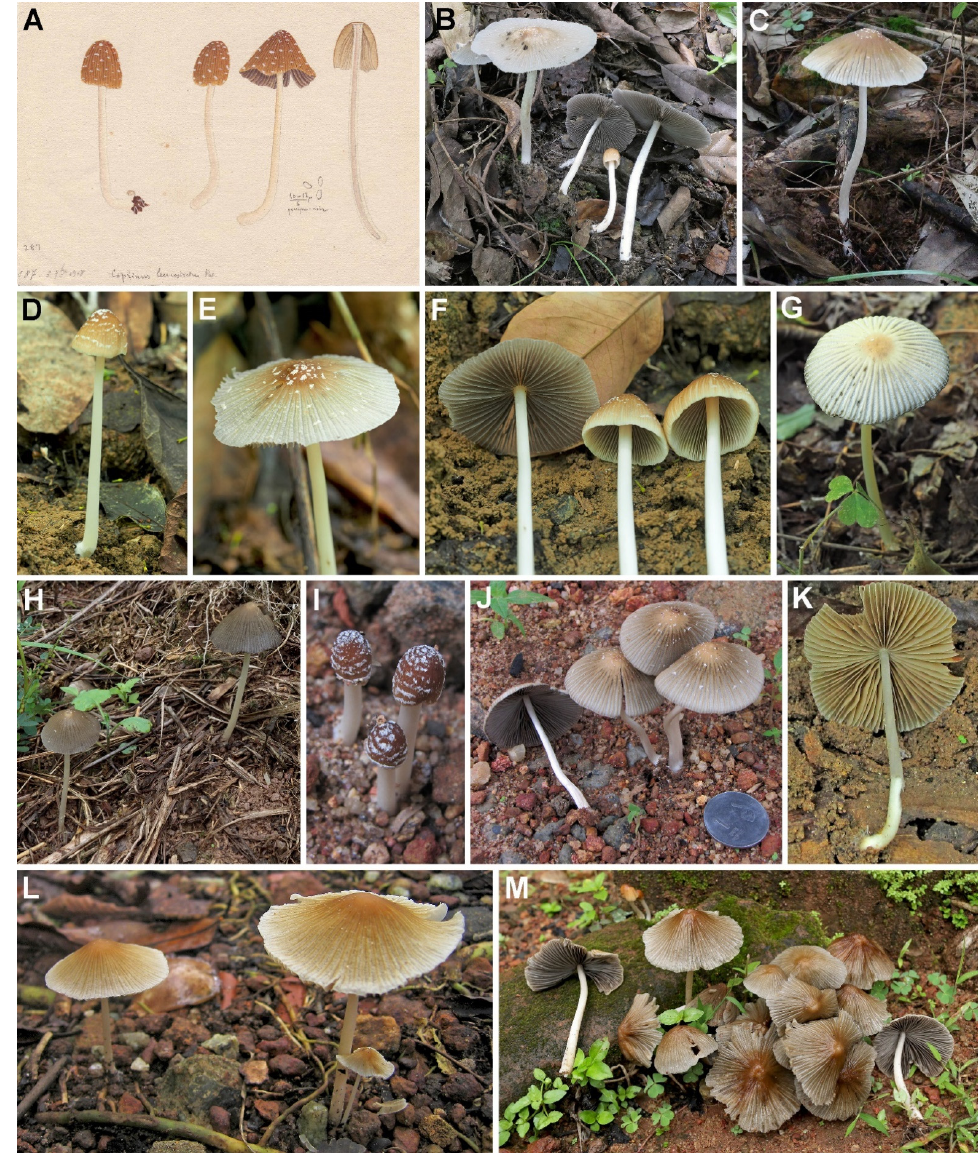
Figure 2. Hausknechtia leucosticta ; basidiomata. ( A ) Original painting of the holotype by V. Demange (1908), from the Farlow Reference Library of Cryptogamic Botany at Harvard University. ( B )